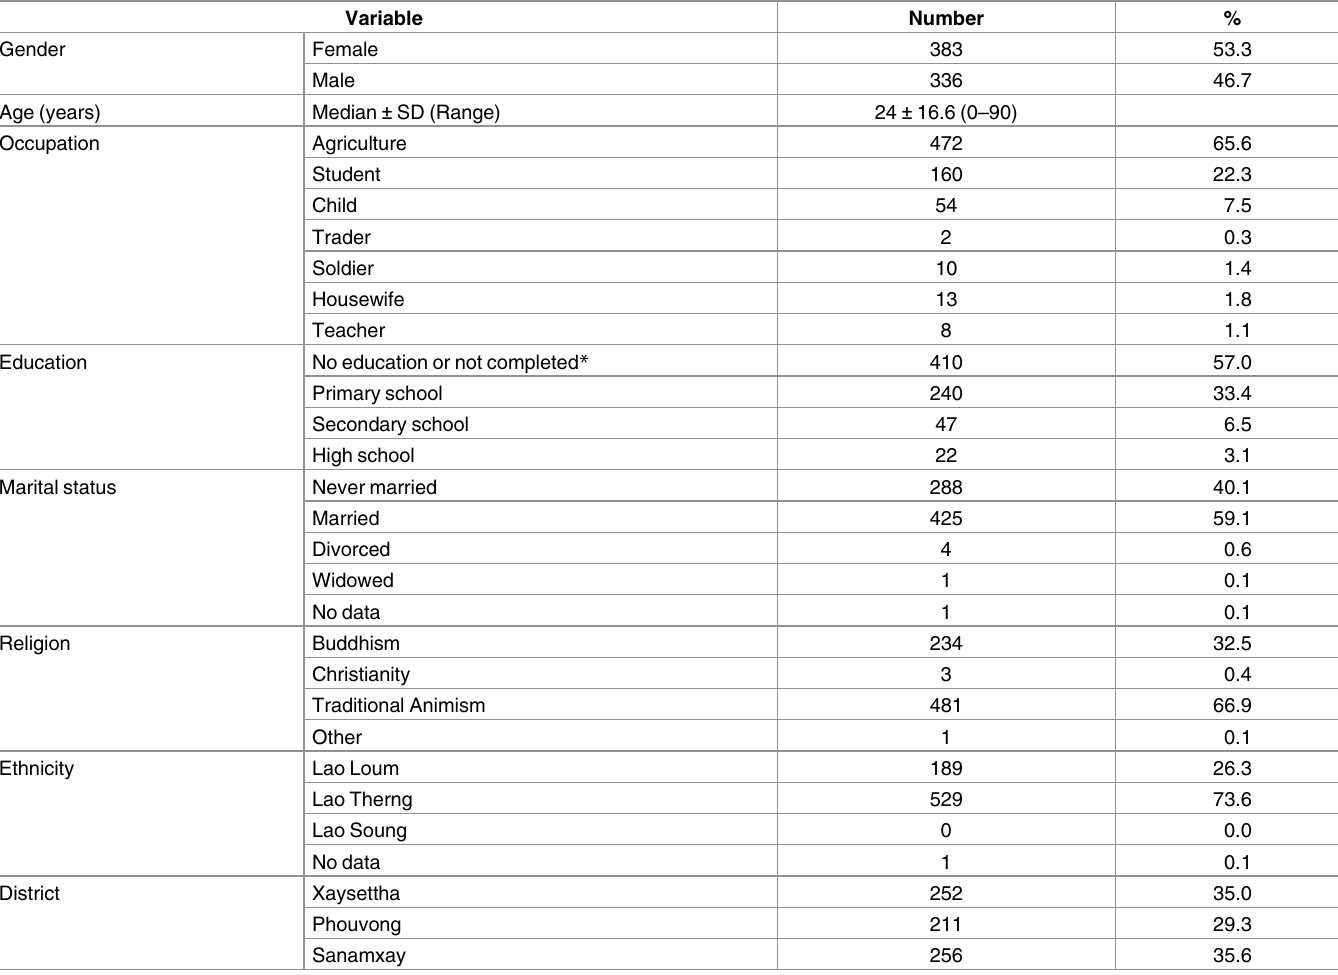
Table 2. The socio-demographic data of the participants (N = 719).